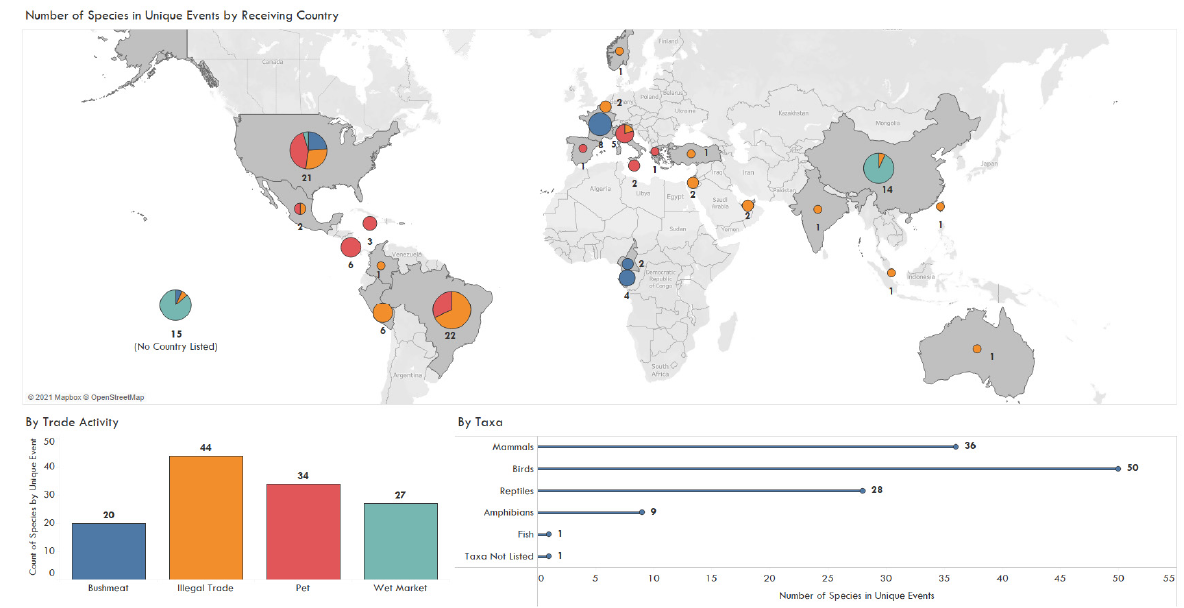
Figure 4. Number of species by taxa and unique trade events including bushmeat, pet trade, wet markets, and other illegal trade, summarized by country of import, 1990–2020.